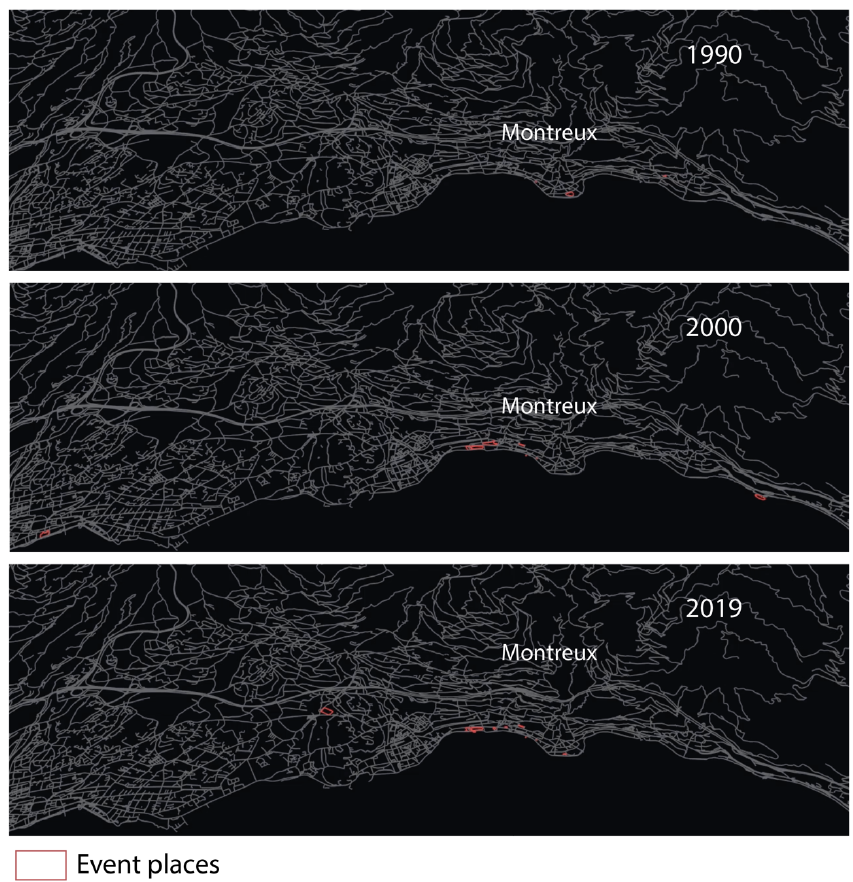
Figure 8. Visualisation attempt using the Time Machine tool. spaces of the Festival. The choice of developing the lake- side as the public space of the Festival appears not only as a scenic choice but also as a good compromise with the localisation of the